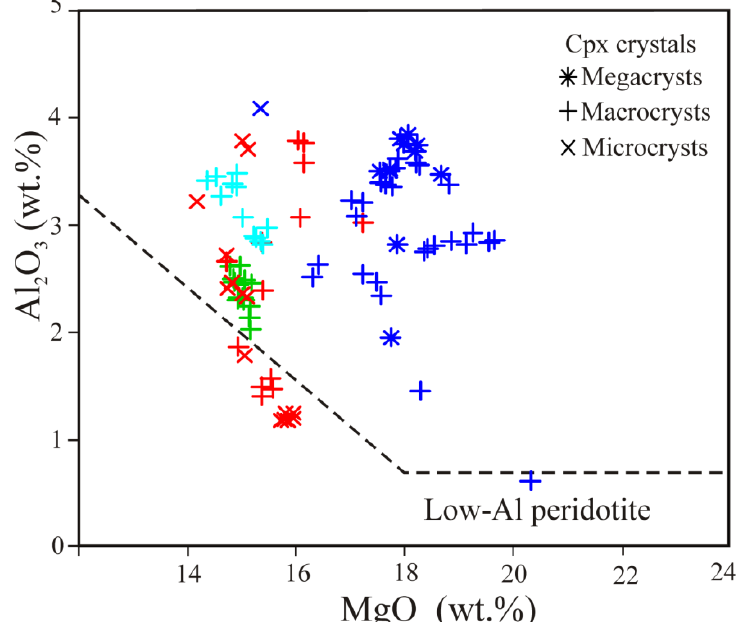
Figure 7. Al O vs. MgO diagram for discrimination of no Low-Al peridotite clinopyroxene 2 3 type for the geothermobarometric calculations based on of single crystals of clinopyroxene (after Nimis